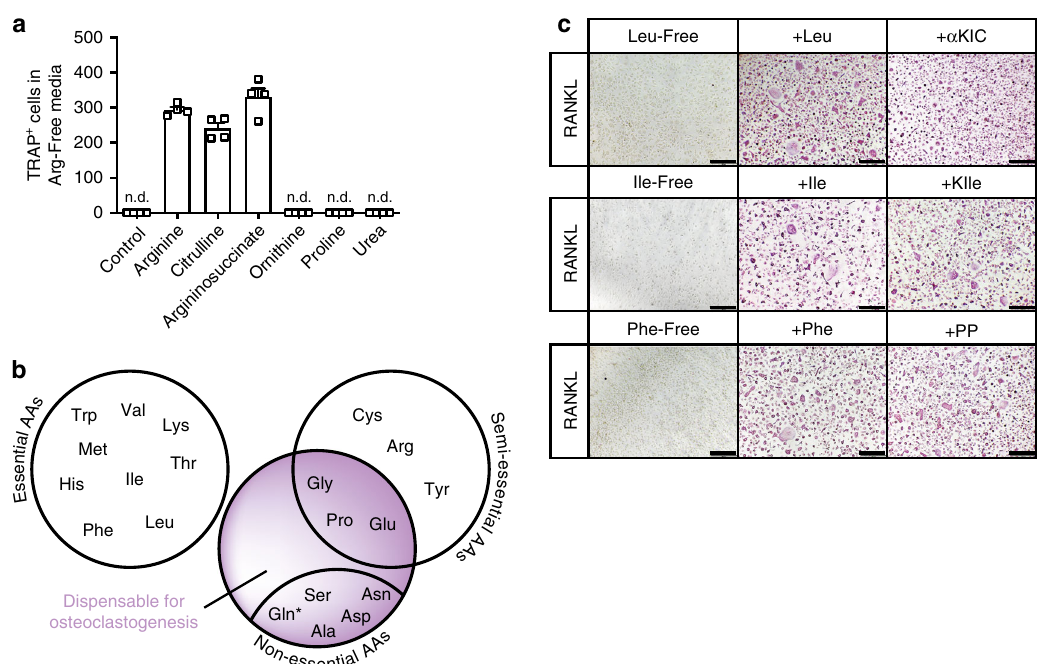
Fig. 6 Intermediates or precursors of amino acids including arginine can compensate for amino acid absence in osteoclastogenesis. a Urea cycle metabolites can/cannot rescue arginine requirements in osteoclastogenesis in Arg-Free media ( n = 4). b Schematic demonstrating which amino acids are essential (white) versus non-essential (pink) for osteoclastogenesis. Star relates to TRAP-positivity with decreased occurrence of MGCs ( n = 4). c Immediate intermediates of leucine, isoleucine and phenylalanine degradation compensate for the lack of these amino acids and rescue osteoclastogenesis. Representative TRAP stainings are shown ( n = 4). aKIC alpha-ketoisocaproate, Ile isoleucine, KIle ketoisoleucine, Leu leucine, Phe phenylalanine, PP phenylpyruvate. Scale bar represents 200 µ m. Data are mean ± SEM. Source data are provided as a Source Data fi